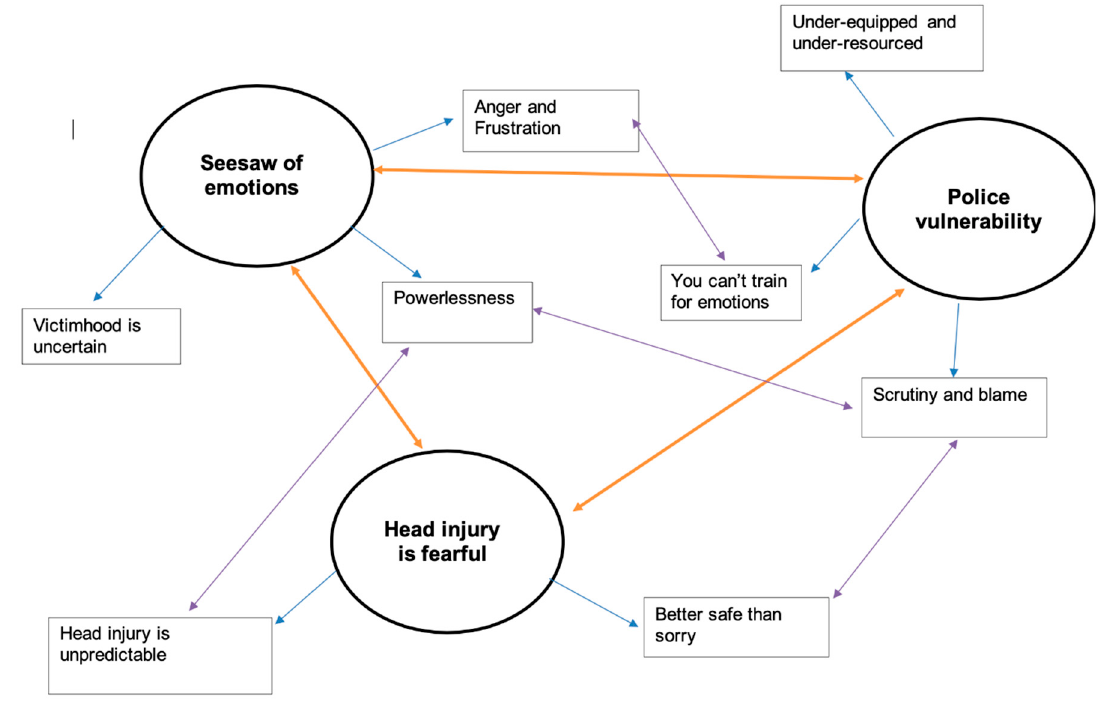
Figure 1. Thematic map of global themes and sub-themes.